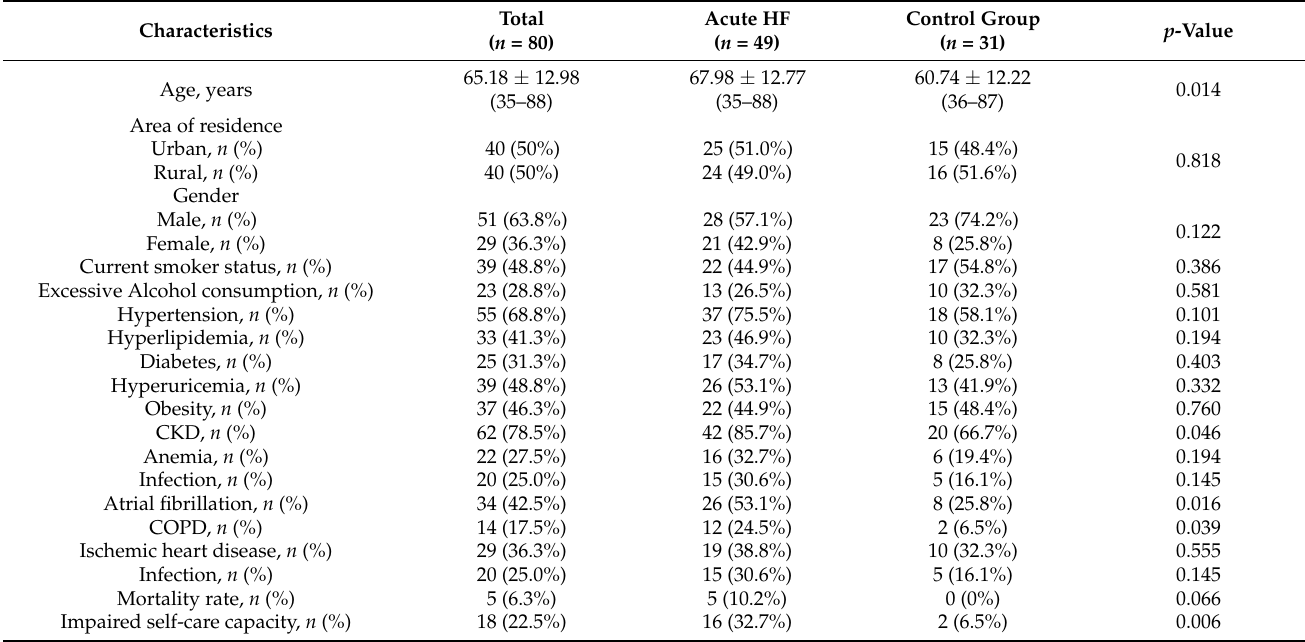
Table 1. Baseline characteristics of patients with acute HF and control